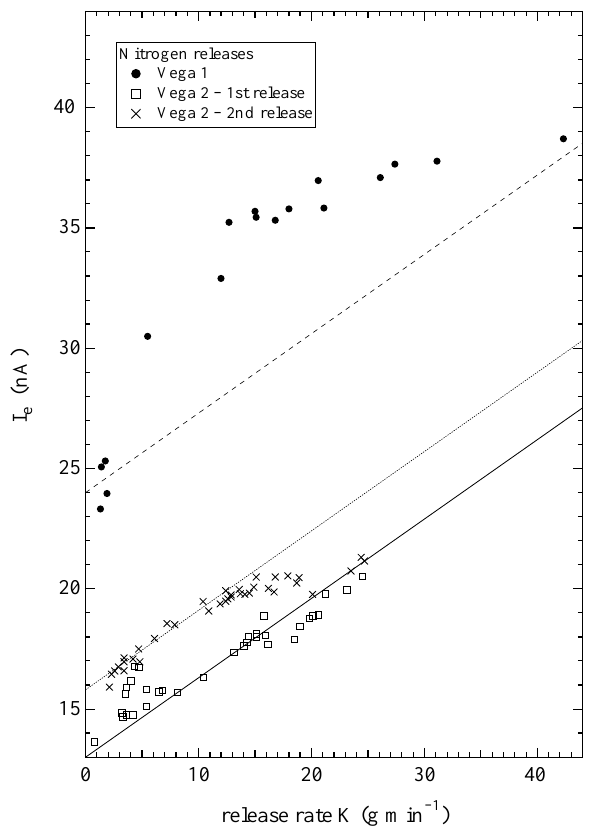
Fig. 5. Electron currents, measured with Langmuir probe L2, against release rate; full circles - Vega 1 release; open squares - first Vega 2 release; crosses - second Vega 2 release.